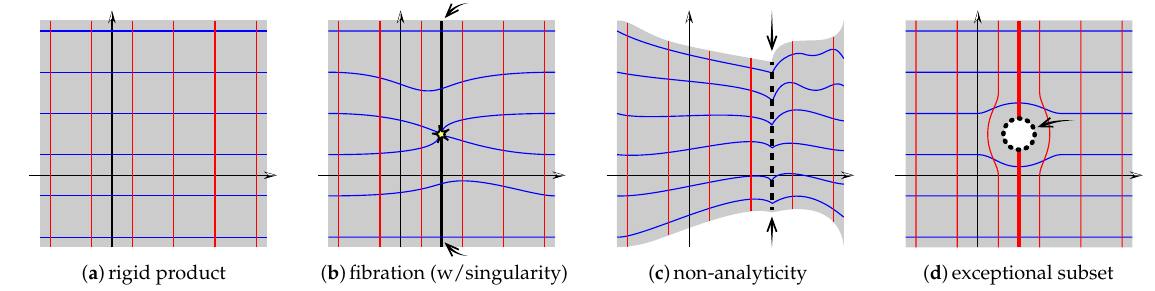
Figure 1. Some possible geometries in target spacetime; these simplified illustrations hint at the variations in any of the relevant structures (complex, Kähler, symplectic, supersymmetry), and may be combined in various